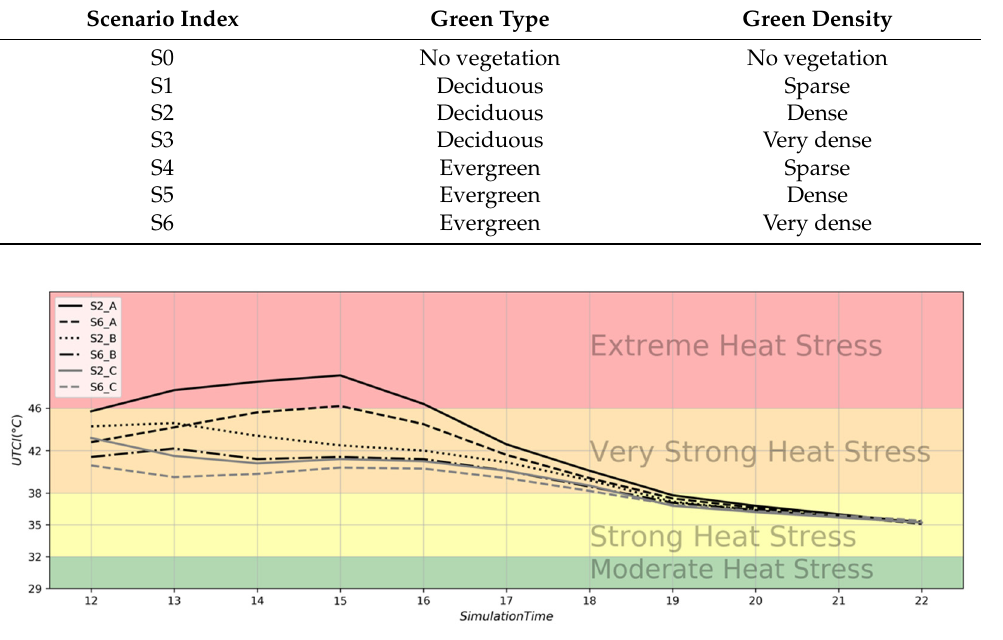
Figure 9. UTCI level change in scenarios with different green types and densities in shallow (A), deep (B), and very deep (C) canyons during simulation